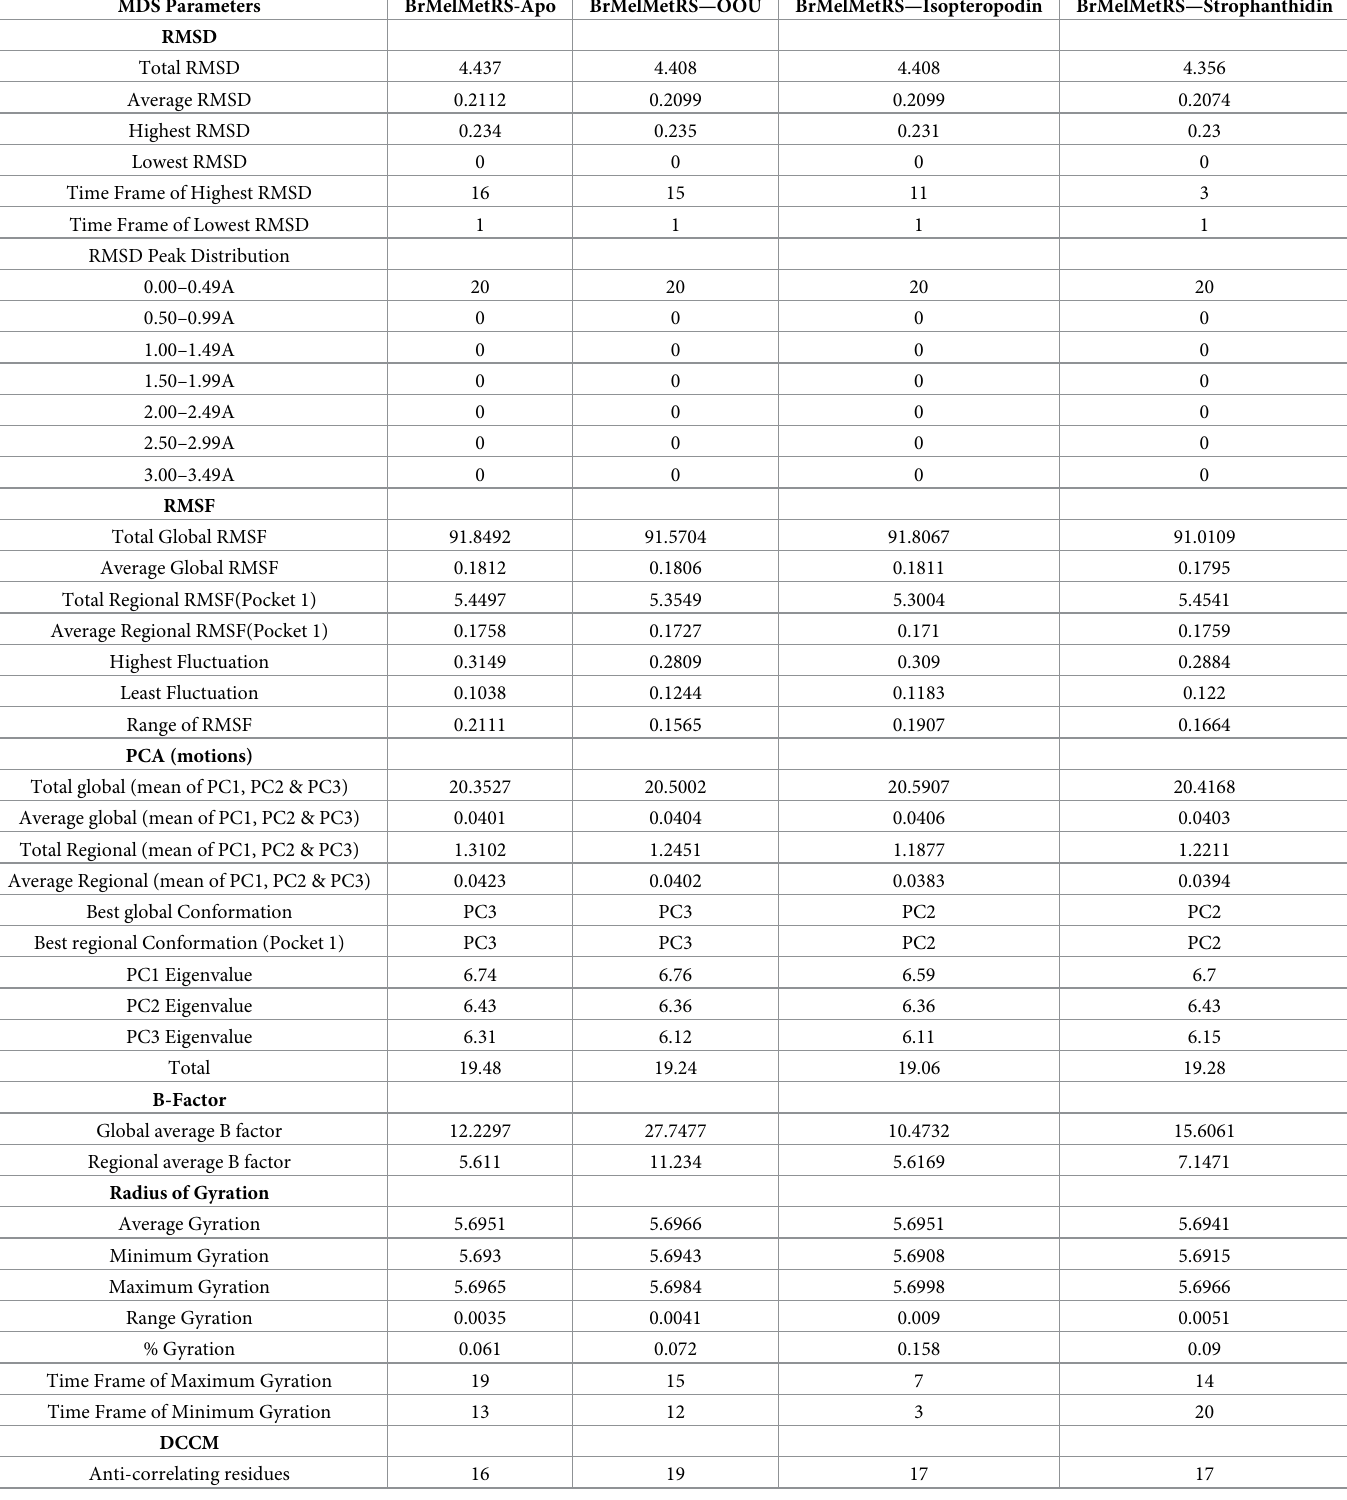
Table 6. MDS of the apo and holo forms of the target (a